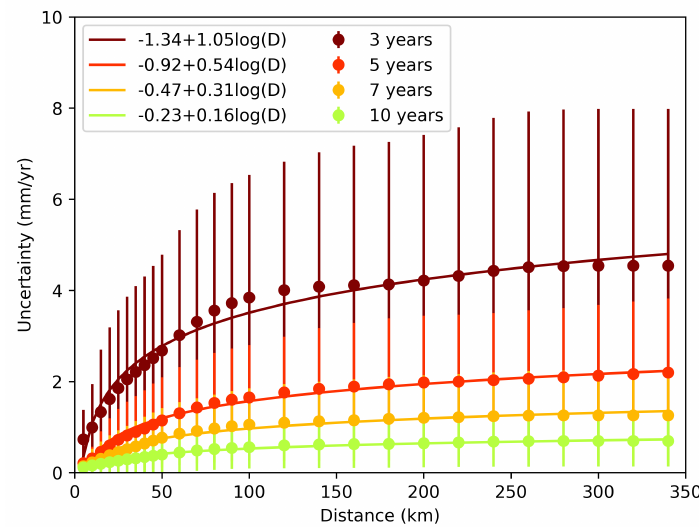
Figure 6. Velocity uncertainties as a function of distance from teh reference point for time-series lengths 3, 5, 7, and 10 years.